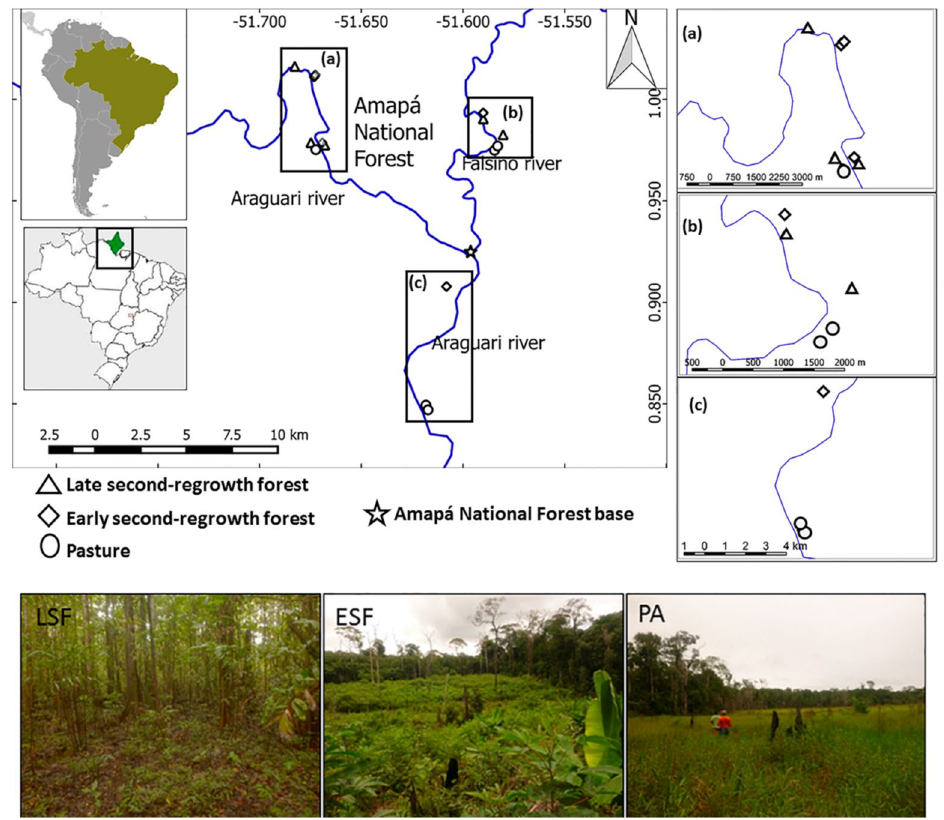
Figure 5. Map of the study area in the eastern Amazon. Showing the location of 15 study sites, grouped into three regrowth stages in the smallholder properties close to rivers (solid blue lines): late second-regrowth forest (LSF, triangles), early second-regrowth forest (ESF, squares) and pasture (PA,